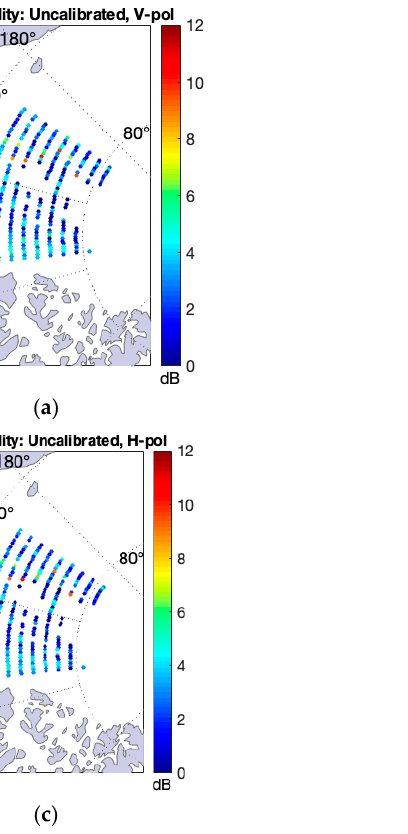
Figure 21. Standard deviation representing the spatial variability observed for February 2018 data: ( a ) uncalibrated V-pol, ( b ) calibrated V-pol, ( c ) uncalibrated H-pol, and ( d ) calibrated H-pol. The spatial variability is analyzed in 1 ◦ × 1 ◦ boxes (lat / lon). Note that calibrated values correspond to radar cross section values after applying calibration Equation (5), under coherent assumption.